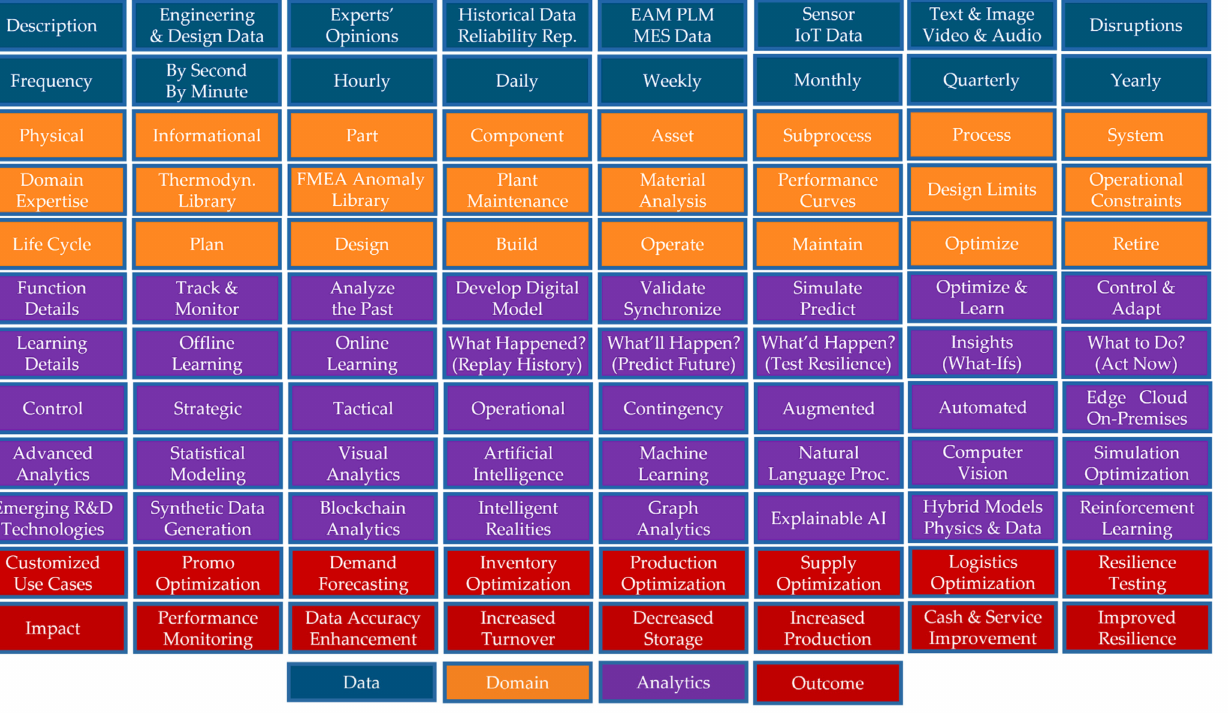
Figure 2. A digital twin development framework built on the four foundational elements